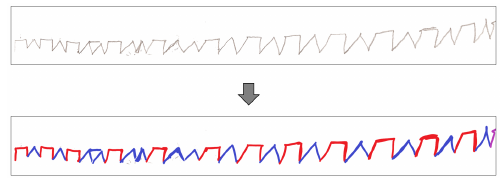
Figure 2. Expert labeling (ground truth